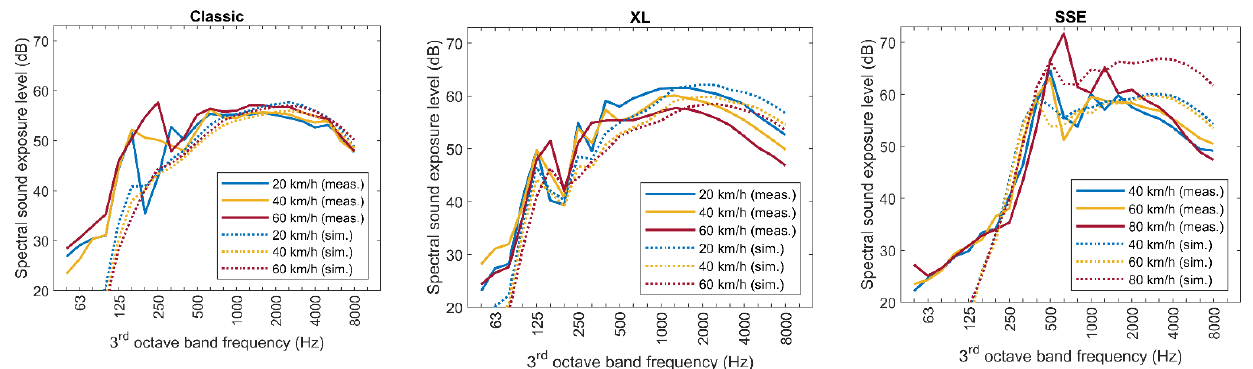
Figure 8. Comparison of the measured vs. simulated spectra of the sound exposure level at micro- phone position M4, shown for all multicopters and three different speeds.